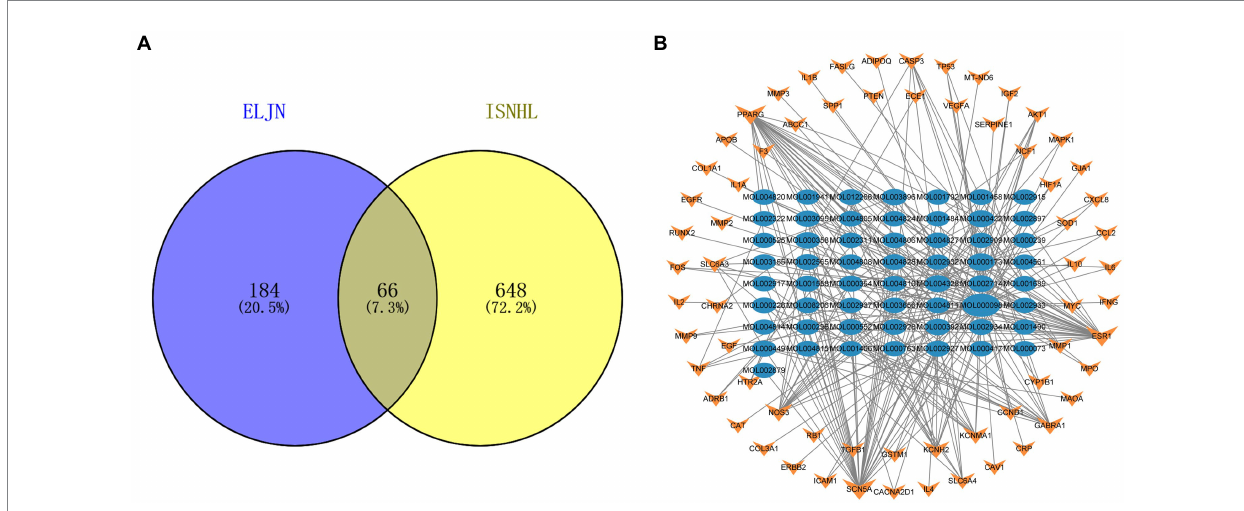
FIGURE 3 Intersection target Venn diagram and the drug components–intersection target network. (A) The purple corresponds to the ELJN targets, while the yellow refers to the ISHL gene targets and the gray is their intersection component. (B) The blue oval corresponds to the drug component, while the orange color refers to the intersection target of the drug and disease. The more lines connected, the stronger the correlation.